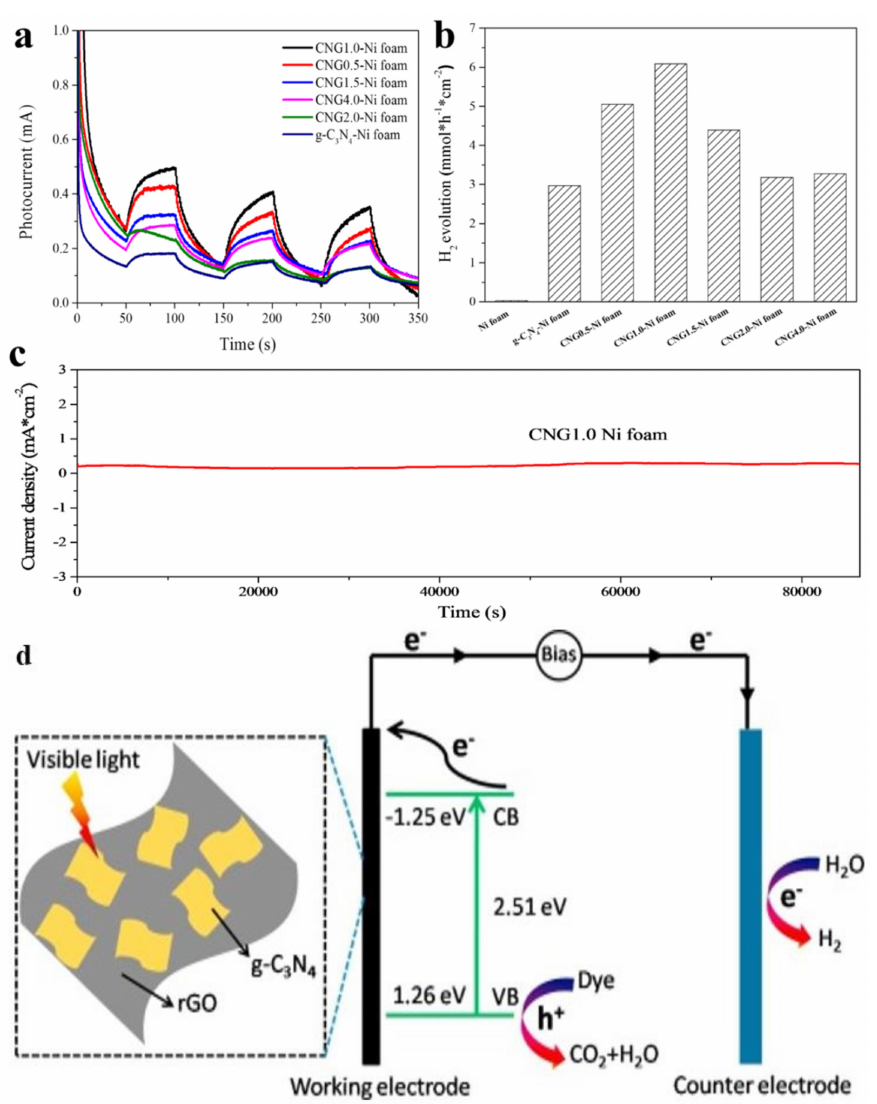
Figure 20. ( a ) Photocurrent responses of CNG1.0-Ni foam electrode and g-C 3 N 4 -Ni foam electrode under visible-light ( λ > 420 nm) irradiation. ( b ) H 2 evolution rates of pure Ni electrode, g-C 3 N 4 -Ni foam electrode and CNG-Ni foam electrode with different percentages of rGO. ( c ) Current density of CNG1.0-Ni foam electrode within 24 h. ( d ) Schematic depiction showing the energy diagram and electron migration process of CNG1.0-Ni foam electrode. (Reprinted with permission from reference [208]. Copyright 2019,